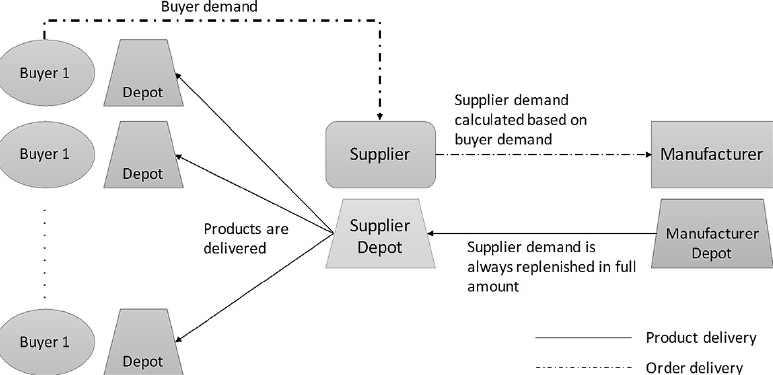
Fig. 2. Resemblance of the traditional system